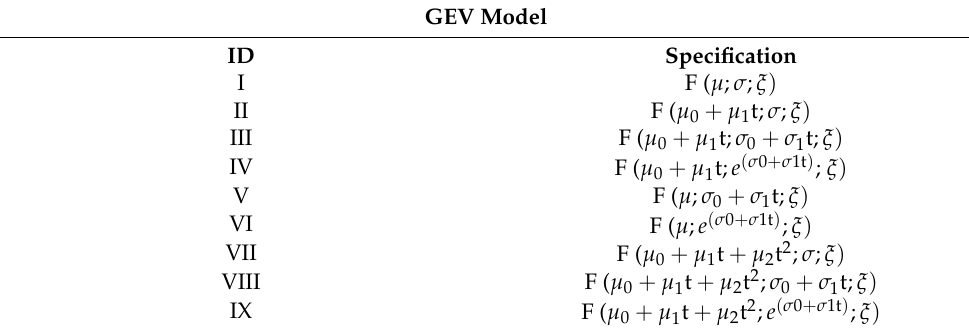
Table 3. List of Generalized Extreme Value (GEV) models used in this study and their parameter combinations. µ , σ , and ξ are the GEV parameters and ‘t’ is the scoring year for which maximum is